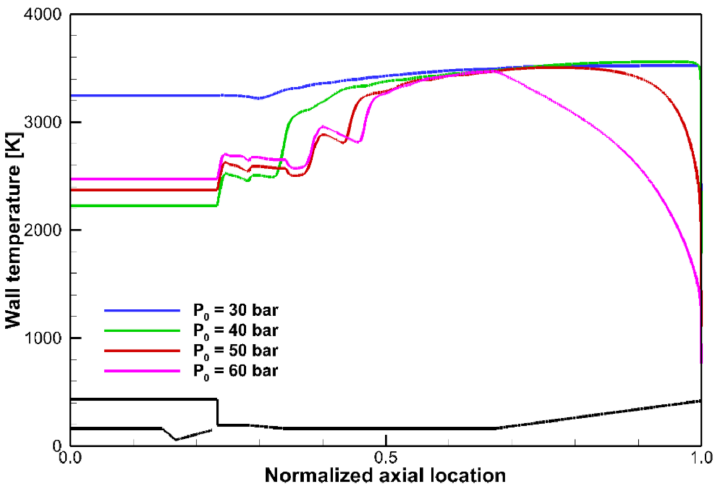
Figure 7. Wall temperature of the baseline diffuser at various operating